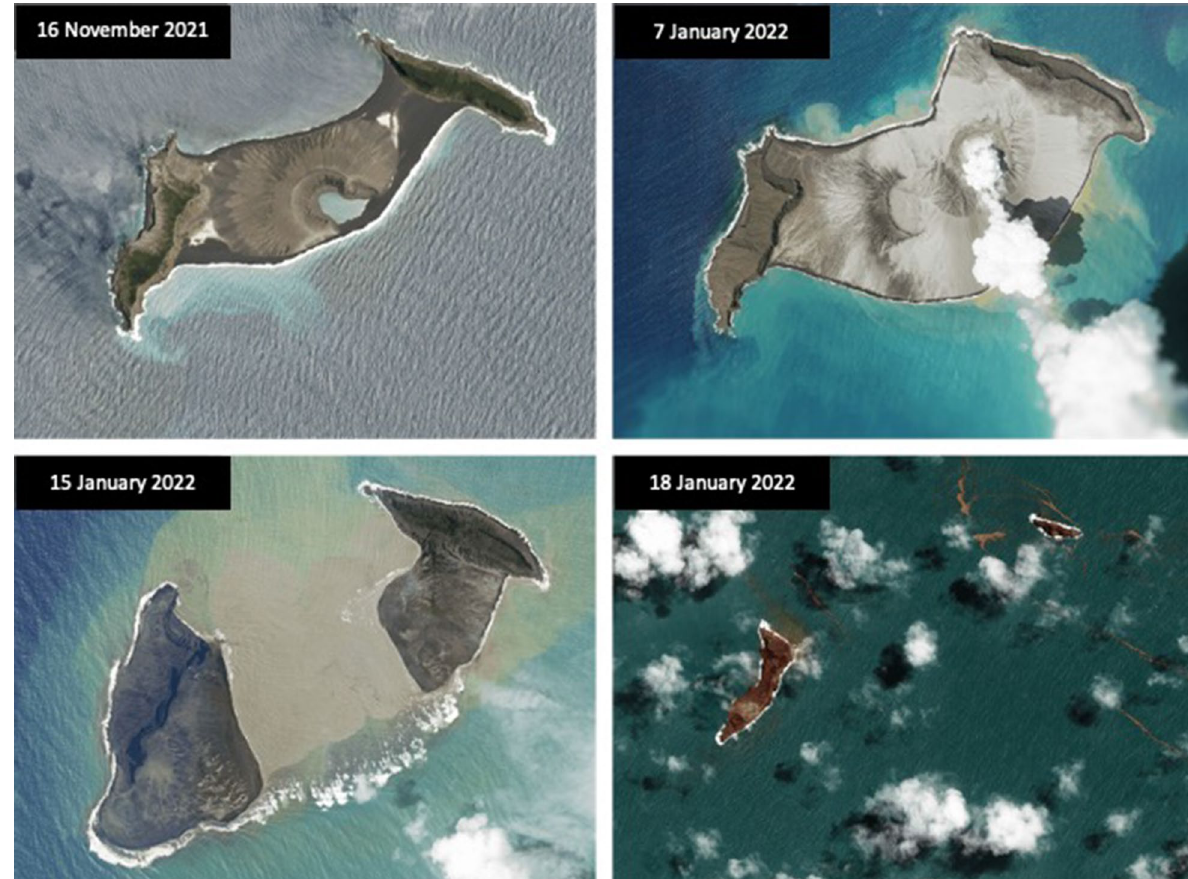
Fig. 6 Evolution and extinction of Hunga-Tonga volcano crater between 16 November 2021 and 18 January